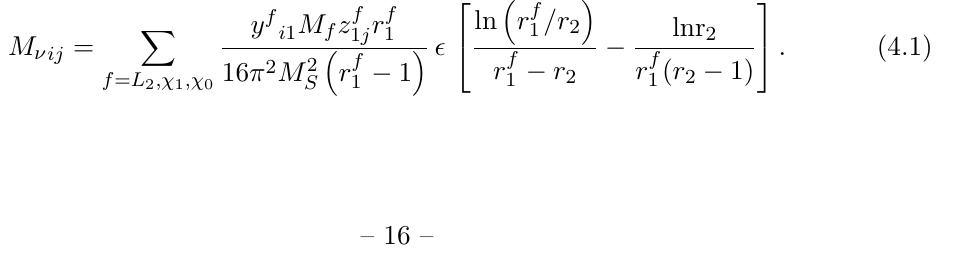
Figure 2 . Radiative mass generation for the neutrinos that adheres lepton number conservation. In the second diagram, neutral fermions are considered where y ( Y )cos θ have been , Y 4( i 1) 6(1 i )